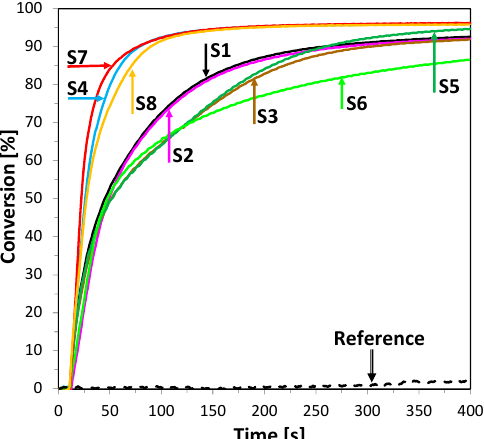
Figure 8. Conversion of double bonds of trimethylolpropane trimethacrylate (TMPTMA) recorded during thiol–ene photopolymerization with PISs based on HIP (1 wt.%) and 2-amino-4,6-diphenyl-pyridine-3-carbonitrile derivatives (0.1 wt.%) under UV-LED 365 nm (intensity at the surface of sample 1.59 mW/cm 2 ) irradiation. The irradiation starts at t = 10 s.